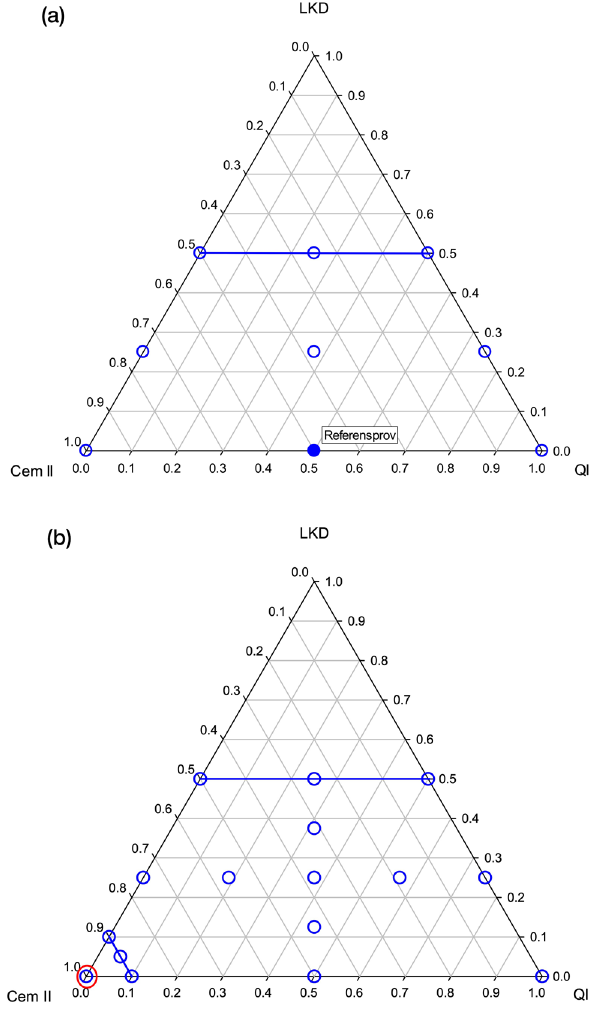
Figure 1: Experimental design: ( a ) according to a restricted simplex centroid design; ( b ) supplemented with internal